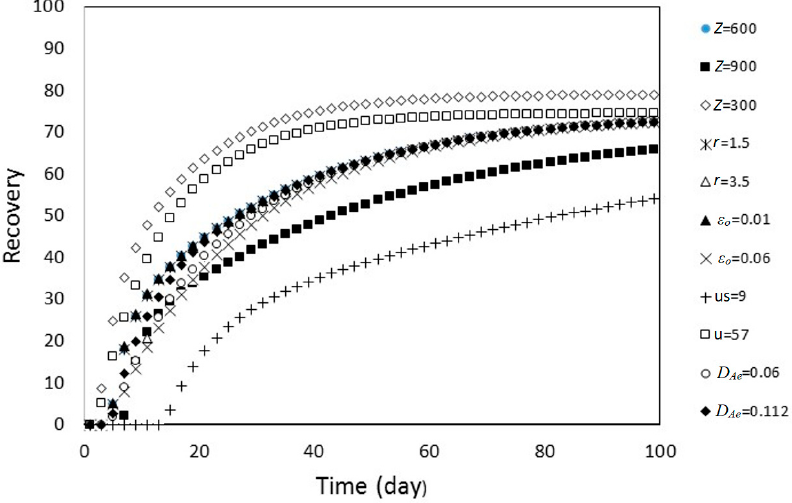
Figure 6. Recovery behavior of heap leaching, cases 1–6.